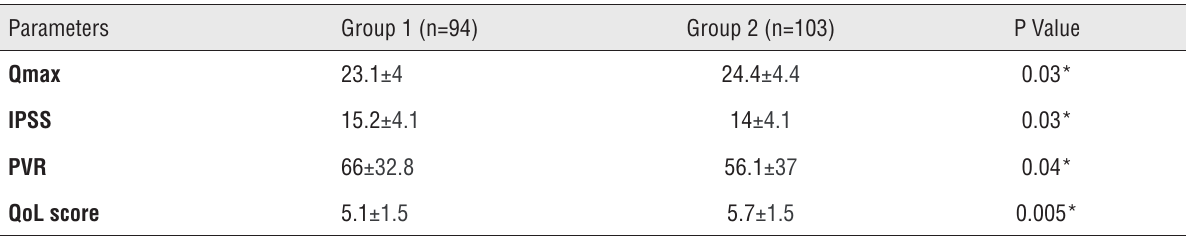
Table 3 - Comparison of uroflowmetry parameters and quality of life index between groups one month after treatment with alpha- blockers.